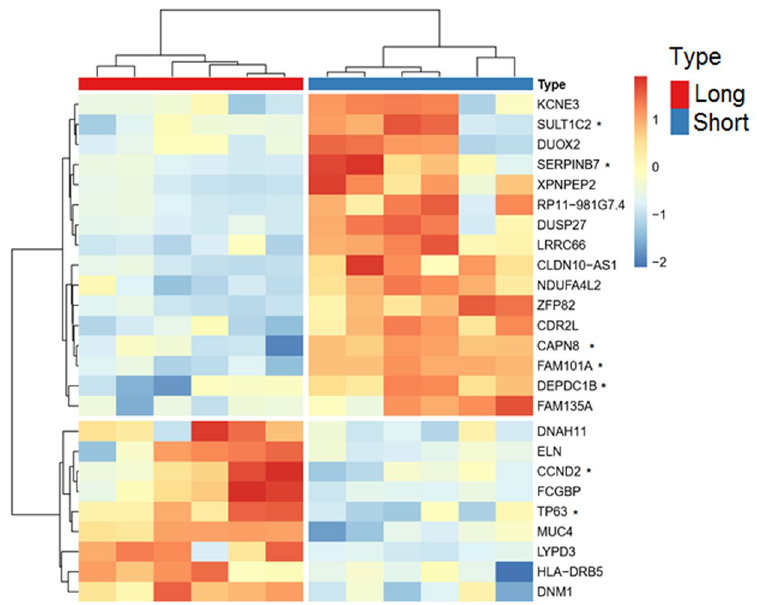
Figure 1. Heat map depicting relative transcript levels of differentially expressed genes in patients with metastatic pancreatic cancer (short vs. long survivors). Lower and higher expression are depicted in blue and red, respectively. Each row indicates a single gene and each column indicates a clinical sample. Each patient was analysed in duplicate. Sample identifiers have been removed. Asterisks indicate the genes which remain significant in the univariate analysis of the validation cohort (non adj. p-value <